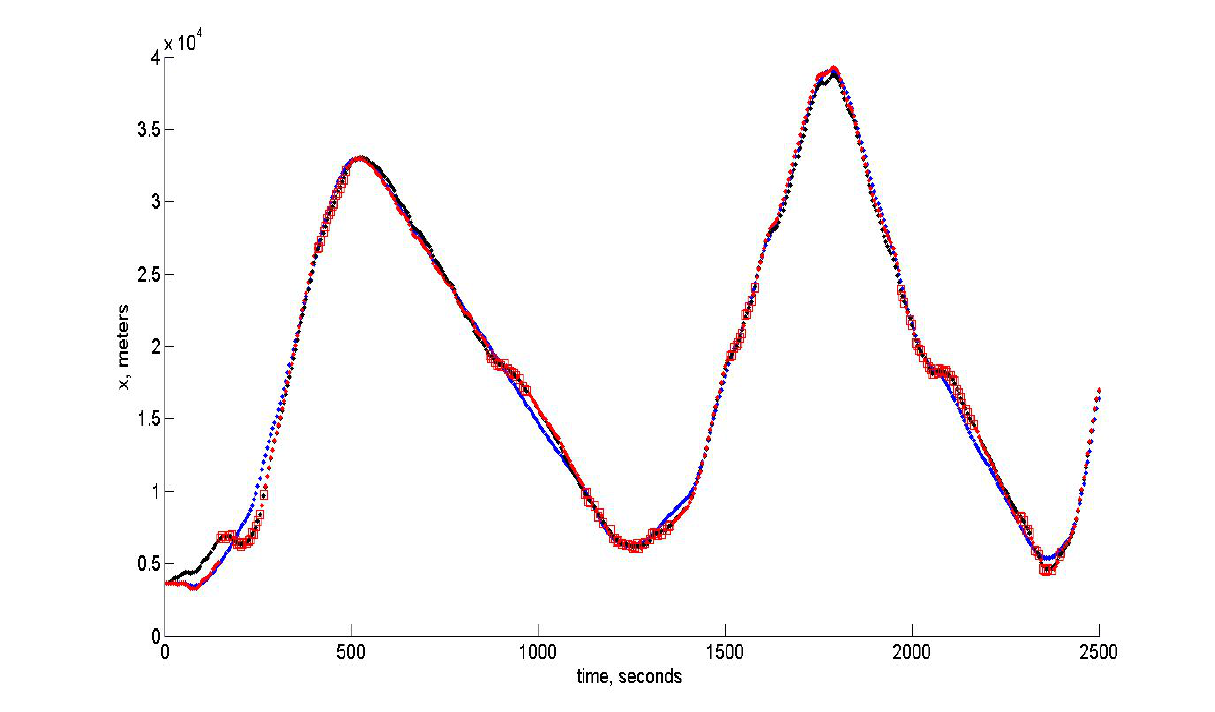
Figure 7. Tracking of the x -coordinate.